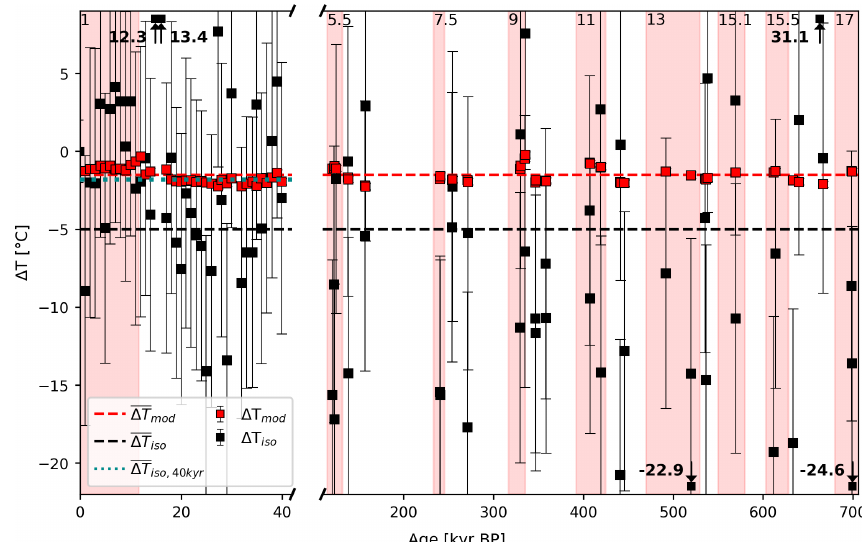
Figure 4. Comparison of the firn temperature difference (cid:49)T mod , as derived from the ice flow–heat flow model of Michel (2016) (red squares), and (cid:49)T iso obtained using measured isotopic ratios only (black squares). Dashed lines in red and black indicate the overall mean values for (cid:49)T mod and (cid:49)T iso , while the dotted line in cyan represents the mean (cid:49)T iso when considering samples from the first 40kyr only. The red shaded intervals and the MIS numbers on top indicate interglacials as identified by Masson-Delmotte et al.